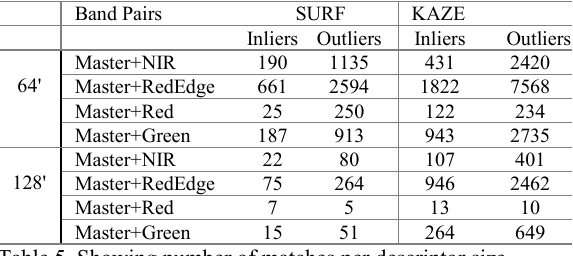
Table 5. Showing number of matches per descriptor size